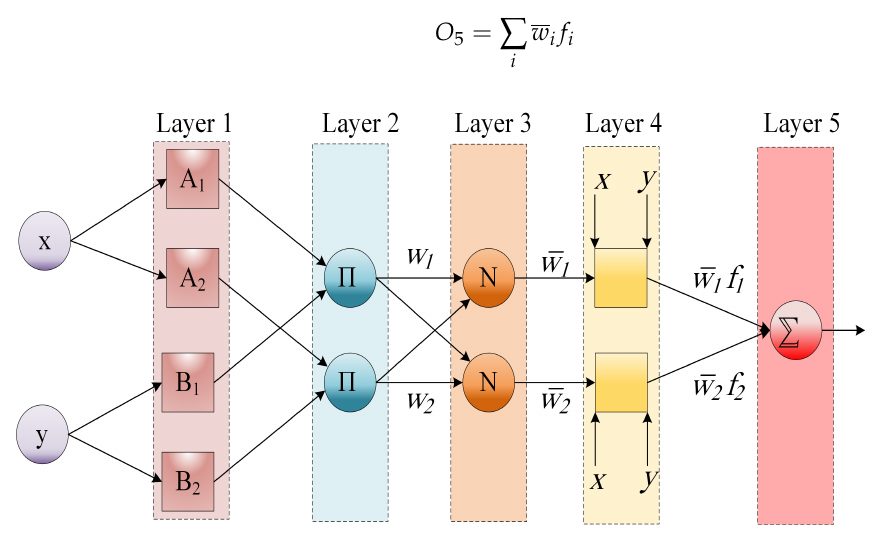
Figure 1. The basic ANFIS